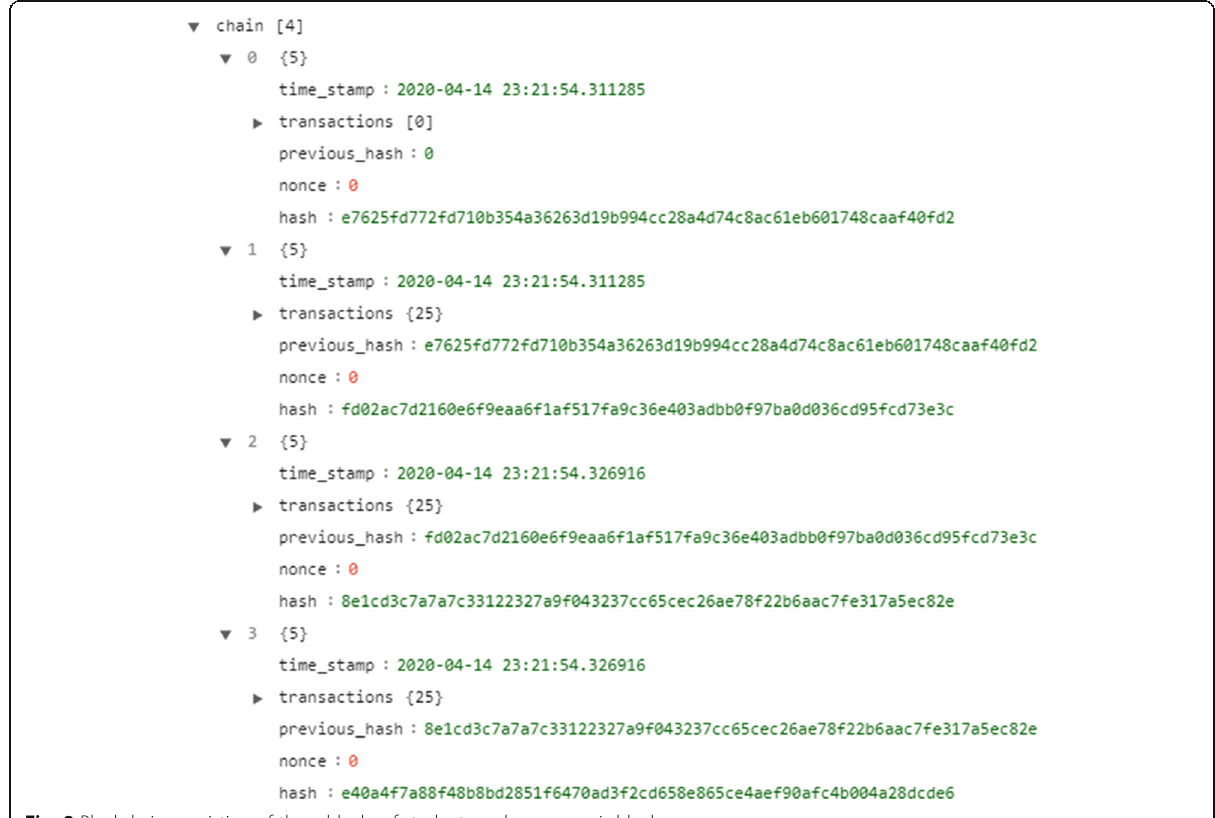
Fig. 8 Blockchain consisting of three blocks of students and one genesis block